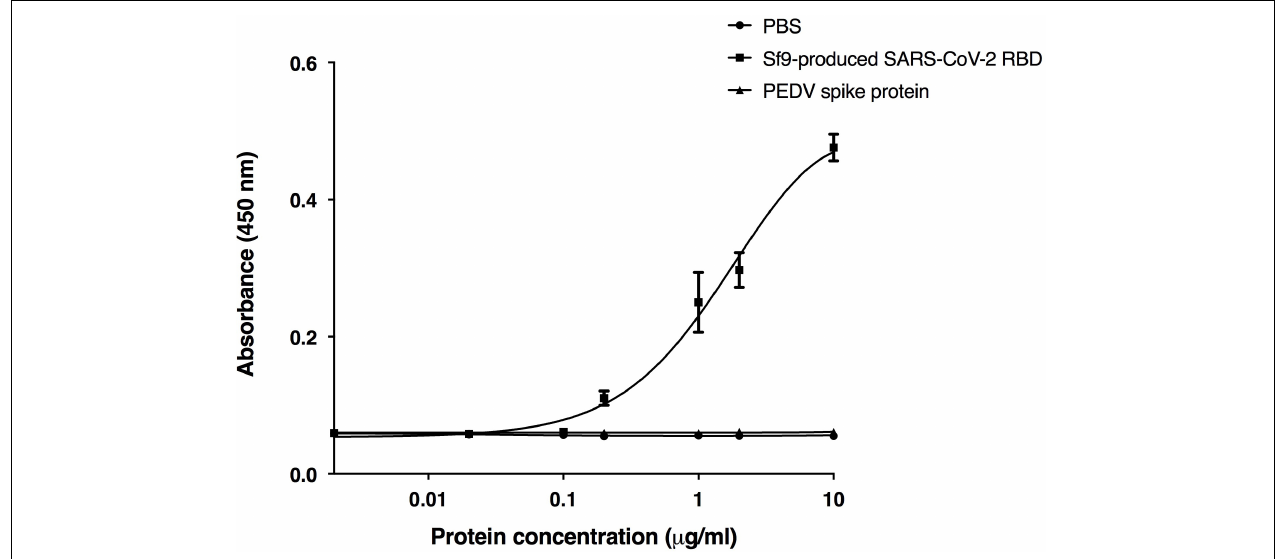
FIGURE 4 | Binding activity of the plant-produced ACE2-Fc with the commercial receptor binding domain of SARS-CoV-2 (SARS-CoV-2 RBD) from Sf9 cells was analyzed by ELISA. PBS buffer and S1 protein of PEDV were used as negative controls. Data are presented as mean ± SD of triplicates.